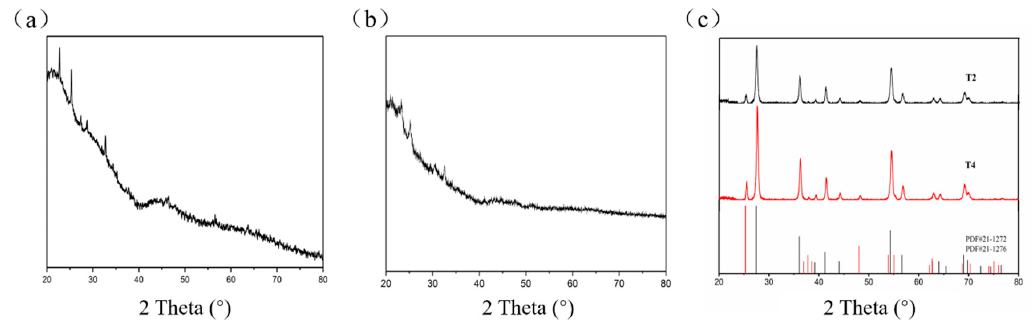
Figure 2. XRD patterns of ( a ) sample T1, ( b ) sample T3, and ( c ) sample T2 and T4.